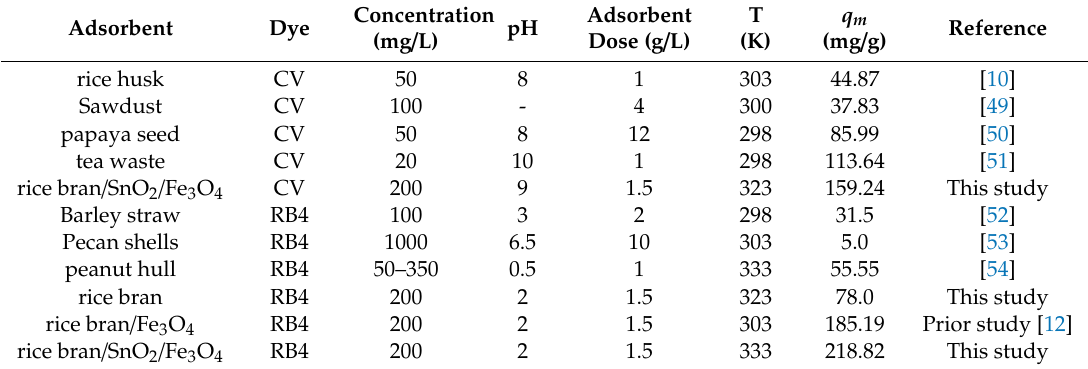
Table 5. Comparison of dye adsorption onto di ff erent